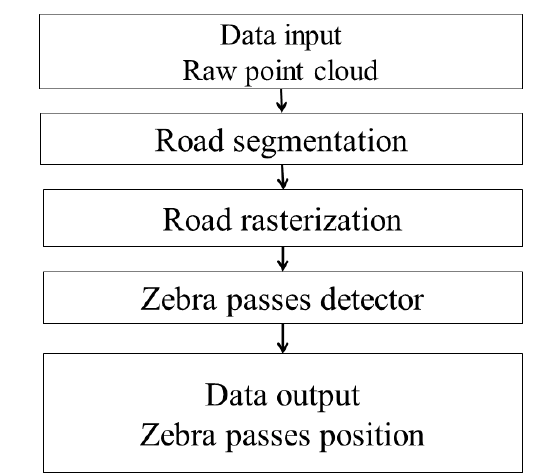
Figure 1. General workflow of the proposed algorithm for zebra crossing detection.